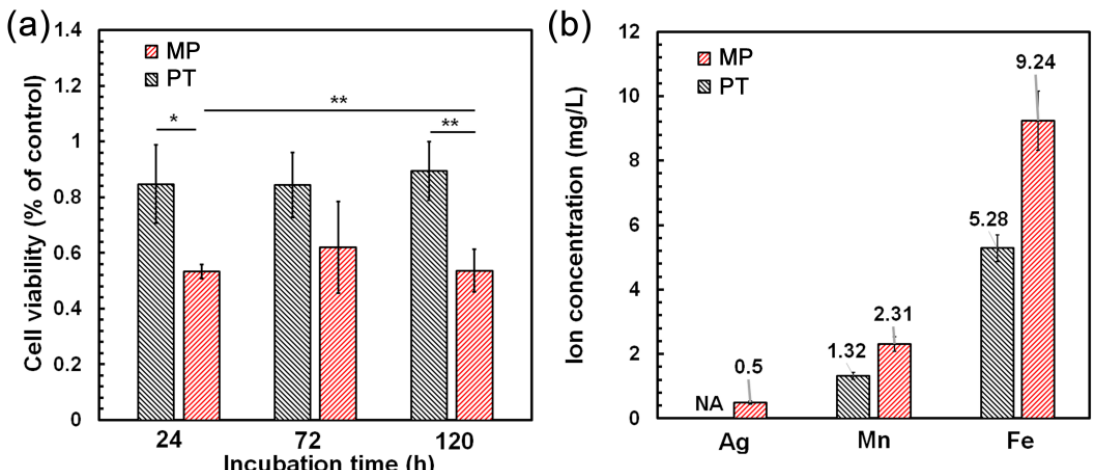
Figure 9. ( a ) Cell viability of the samples after 24, 72 and 120 h of incubation with HUVECs (n = 3, *: p < 0.05; **: p < 0.01) and ( b ) ion release after 24 h immersion of the samples (NA: No Ag detected).